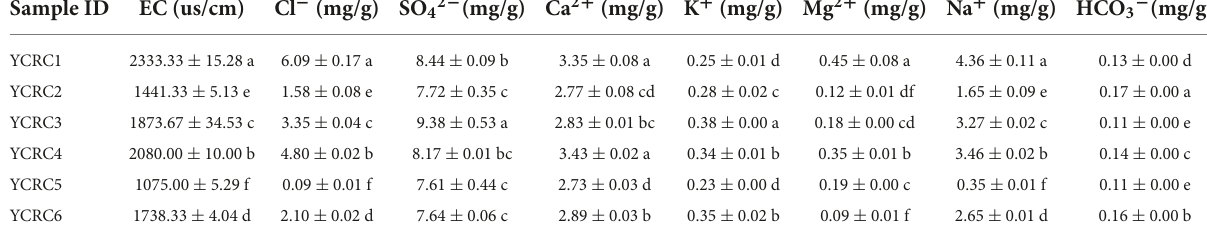
TABLE 2 Electrical conductivity and major ions of soil samples.